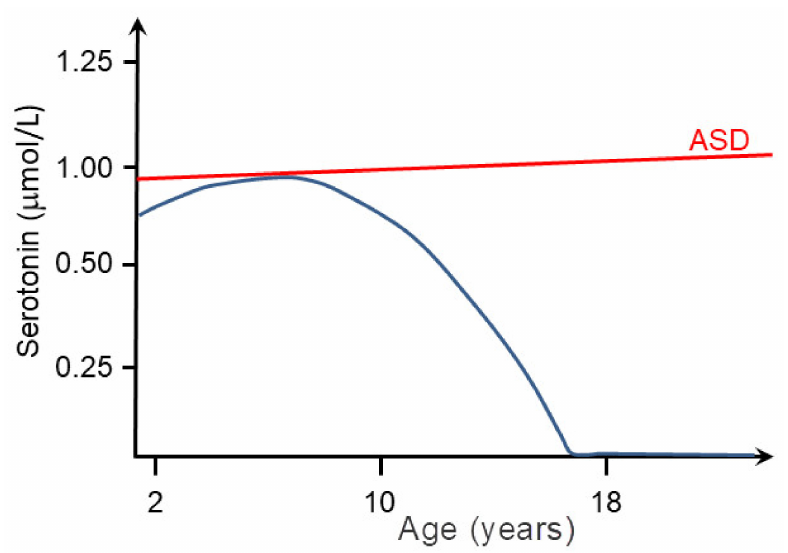
Figure 10. Schematic representation of increased serotonin levels in the blood (hyperserotonemia) in individuals with autism spectrum disorder (ASD). The blue curve presents the concentration of serotonin in the blood in control subjects. Graph based on Laboyer et al. (1999)